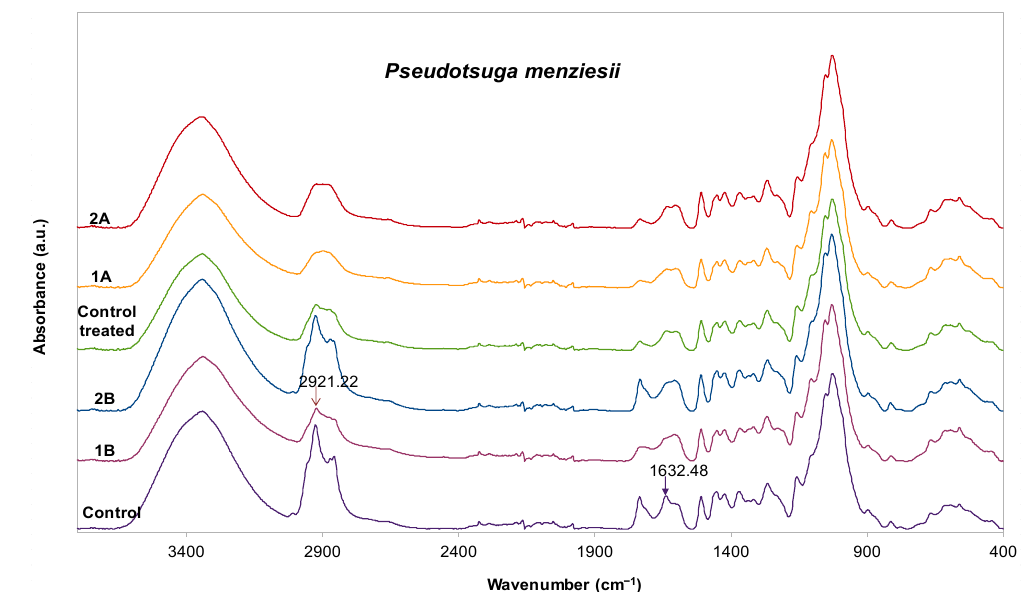
Figure 4. Spectral band assignments of the main spectral peaks observed in the Douglas fir wood FTIR spectra. 1A—Fe 2 O 3 ;